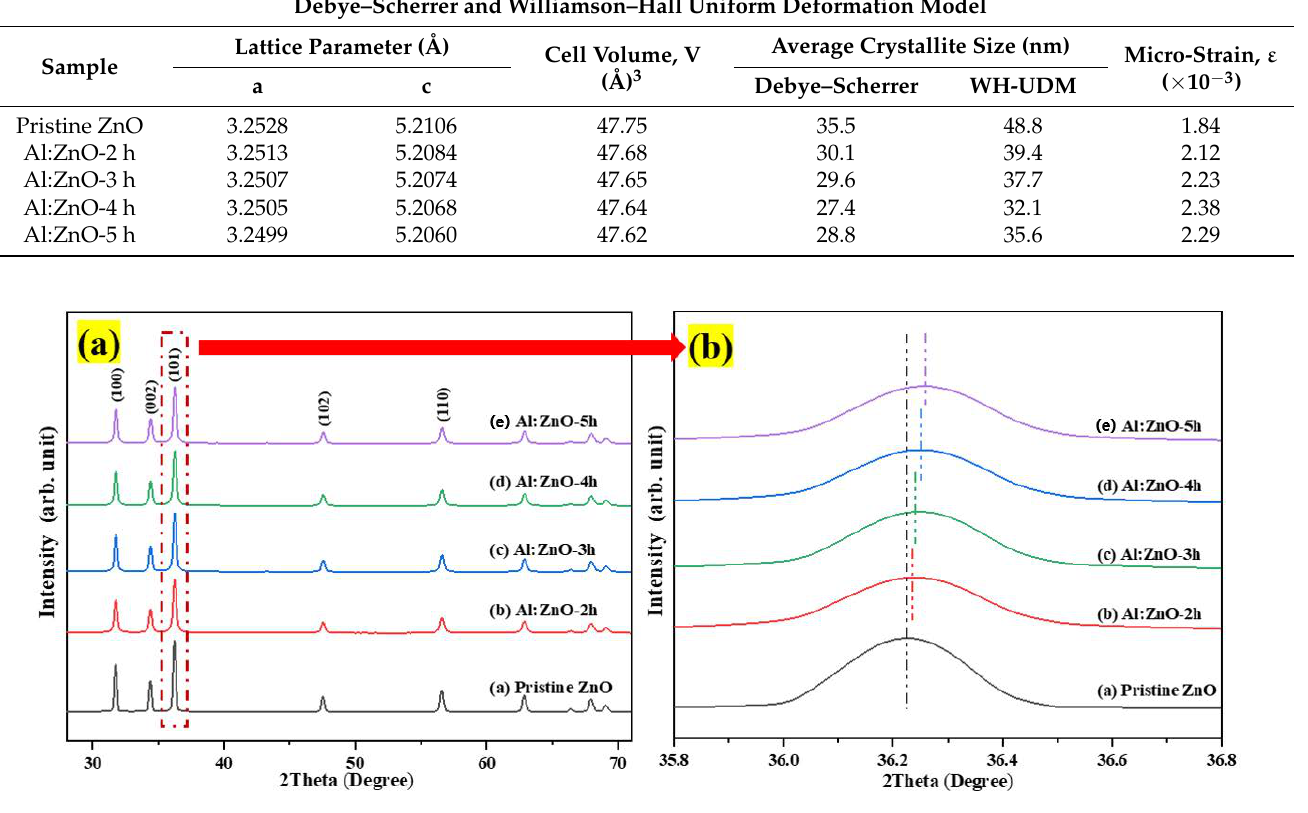
Figure 3. ( a ) X-ray diffraction pattern of the pristine ZnO and Al:ZnO nanostructures with varying immersion time; ( b ) magnification of peak